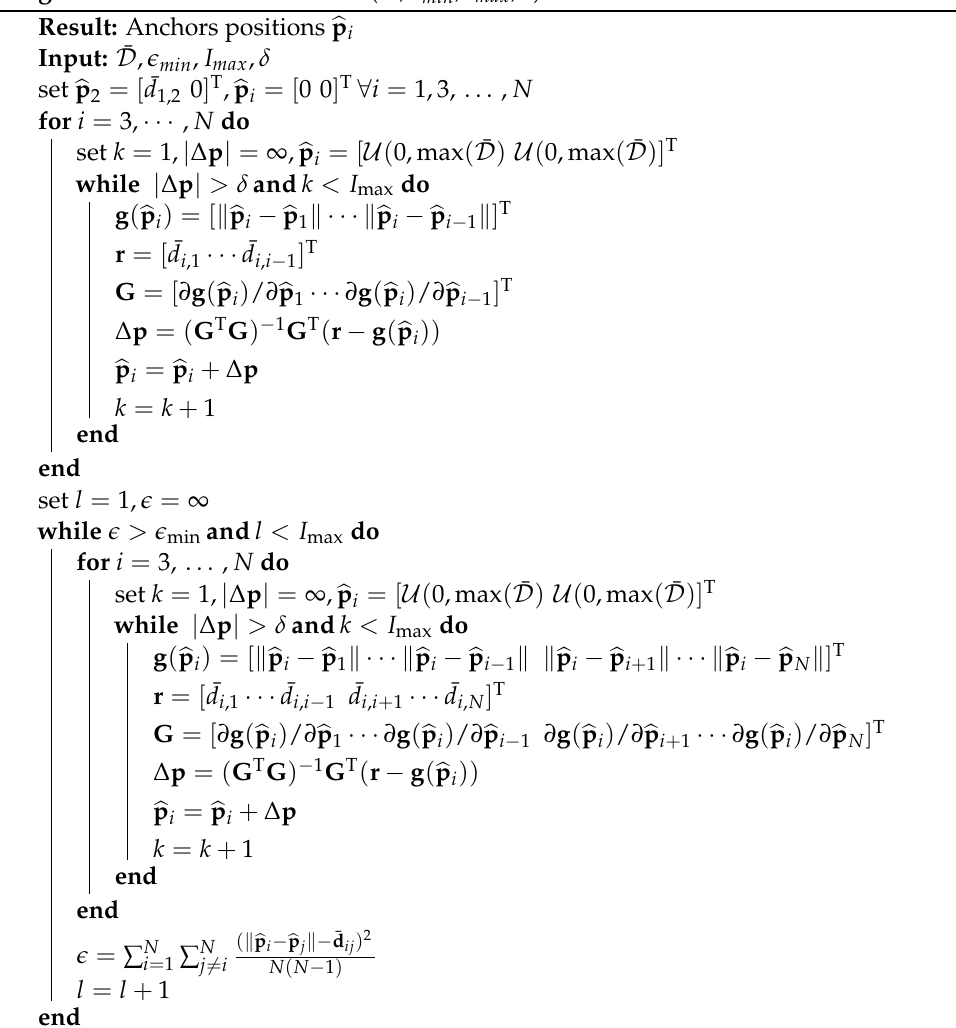
Algorithm 2: Autolocalization ( ¯ D , (cid:101) min , I max , δ